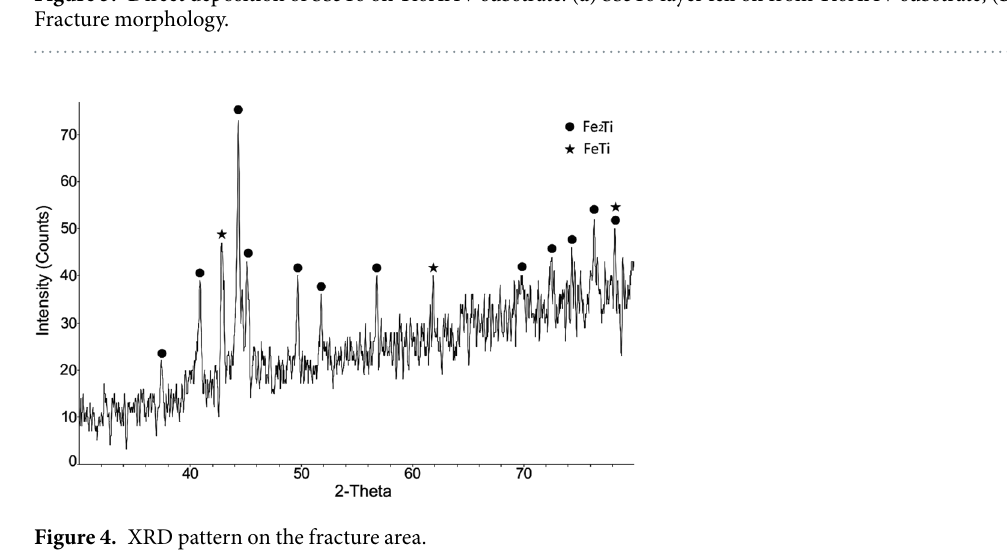
Figure 4. XRD pattern on the fracture